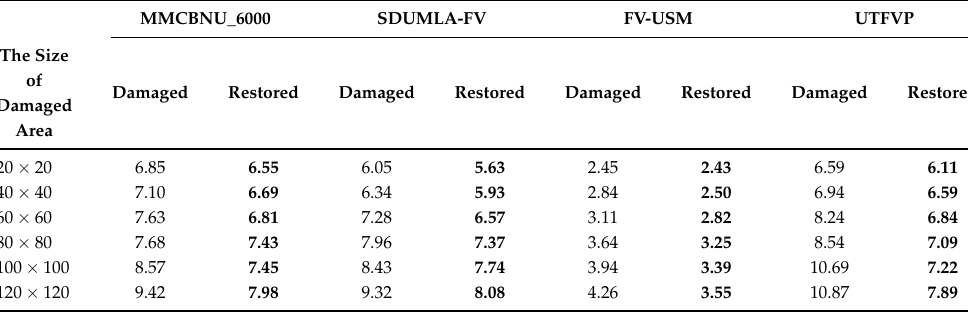
Table 8. EERs (%) of the right damaged area on the different public datasets. MMCBNU_6000 The Size of